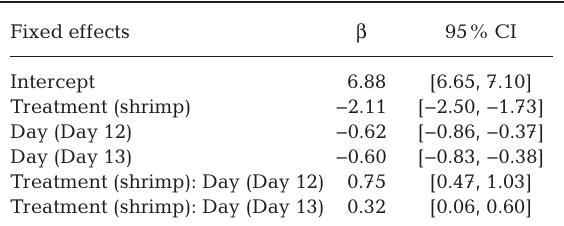
Table 1. Fixed effects regression